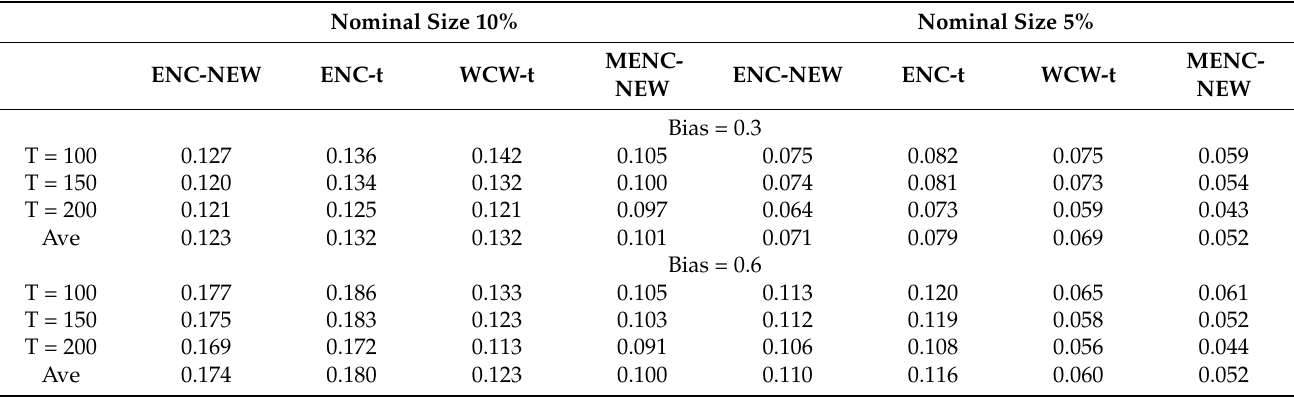
Table 3. Empirical Size for P/R =